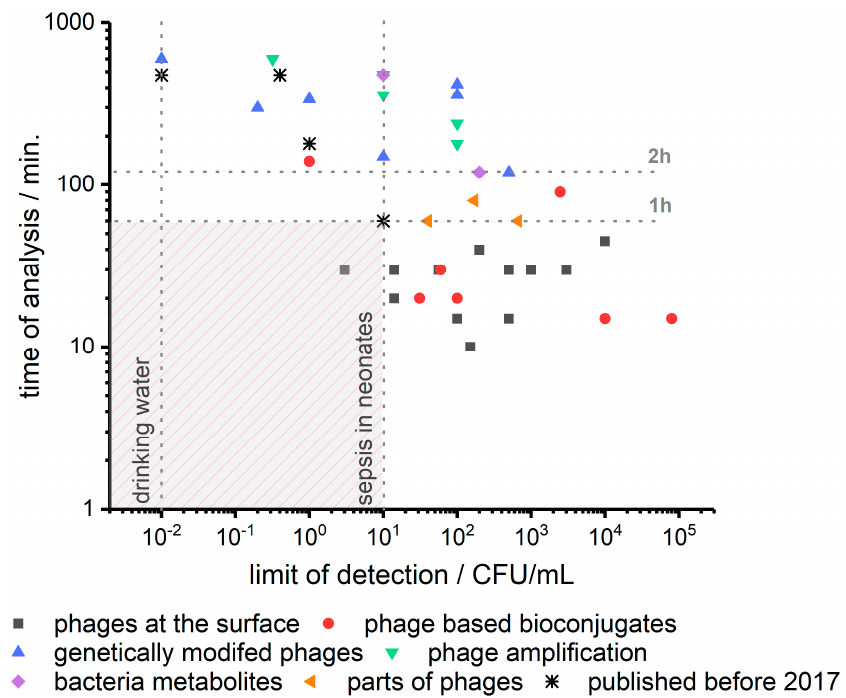
Figure 3. The relation between time of analysis and limit of detection of phage ‐ based biosensors reported in scientific publications shown in Table 1. Recent advances in phage ‐ based biosensors ʹ development bring us closer to fast and sensitive methods for bacteria detection. To achieve detection in the range below 10 CFU/mL in time below 1 h is still a crucial